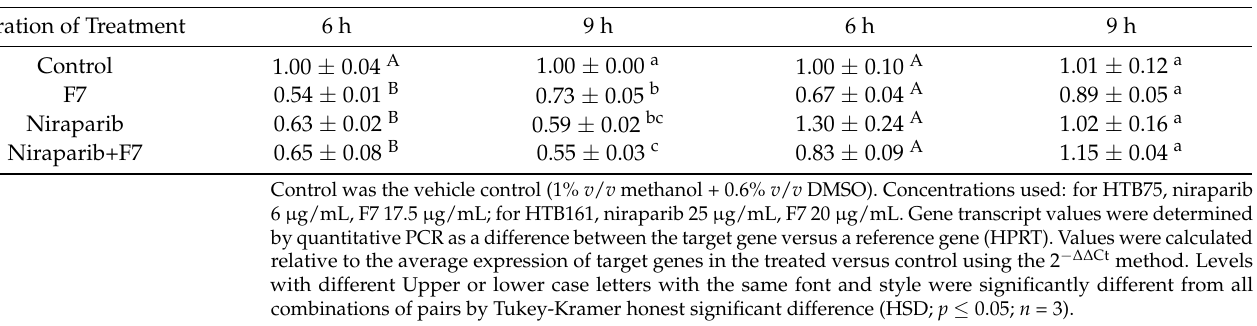
Table 2. Quantitative PCR determination of the RNA steady state level in HTB161 and HTB75 cell lines of RAD51 gene, after treatment with F7 and/or niraparib for 6 and 9 h relative to control. RAD51 Expression in HTB161 (Mean ± SE) RAD51 Expression in HTB75 (Mean ± SE) Duration of Treatment 6 h 9 h 6 h 9 h